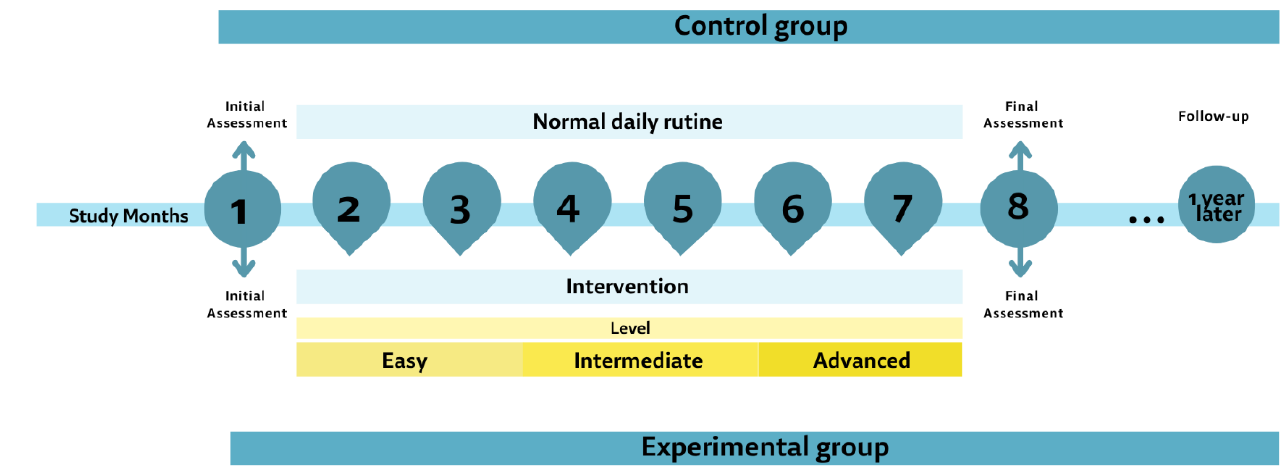
Figure 1. Study timeline graph.